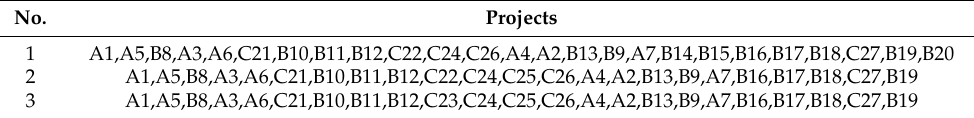
Table 3. Results of cohesive